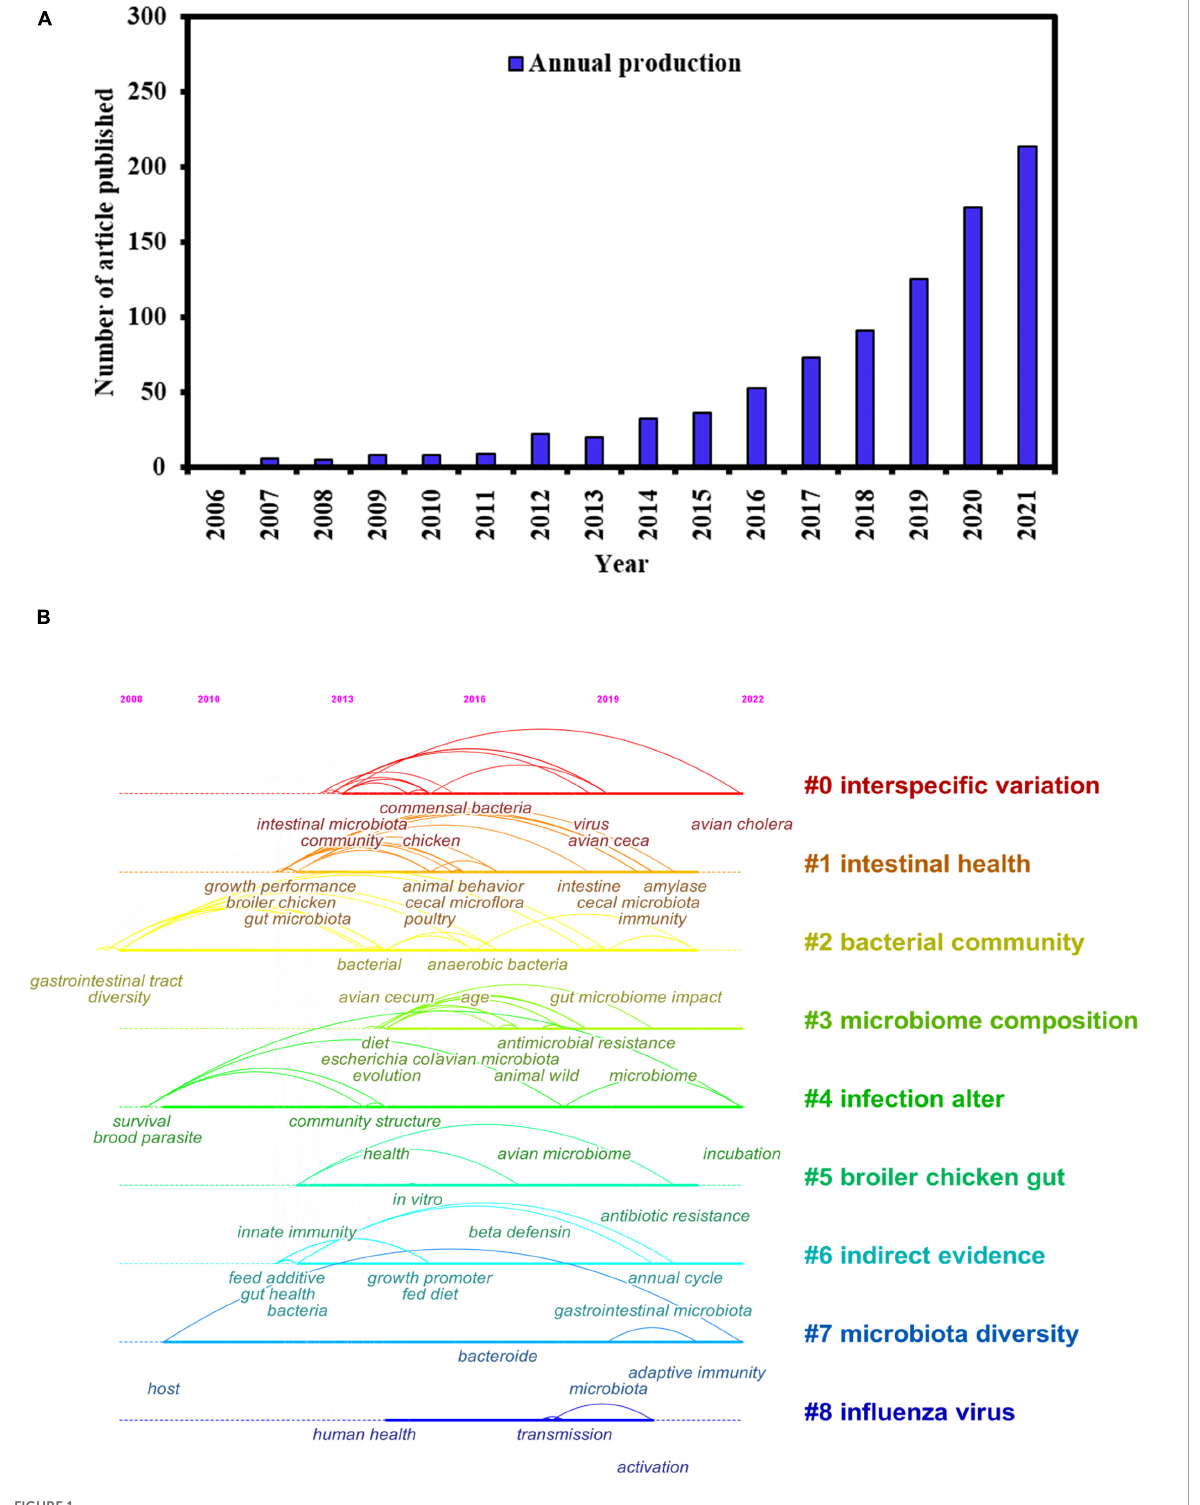
FIGURE1 (A) Number of articles published on avian gut microbiota from 2006 to 2022. (B) The evolution of avian gut microbiota over the